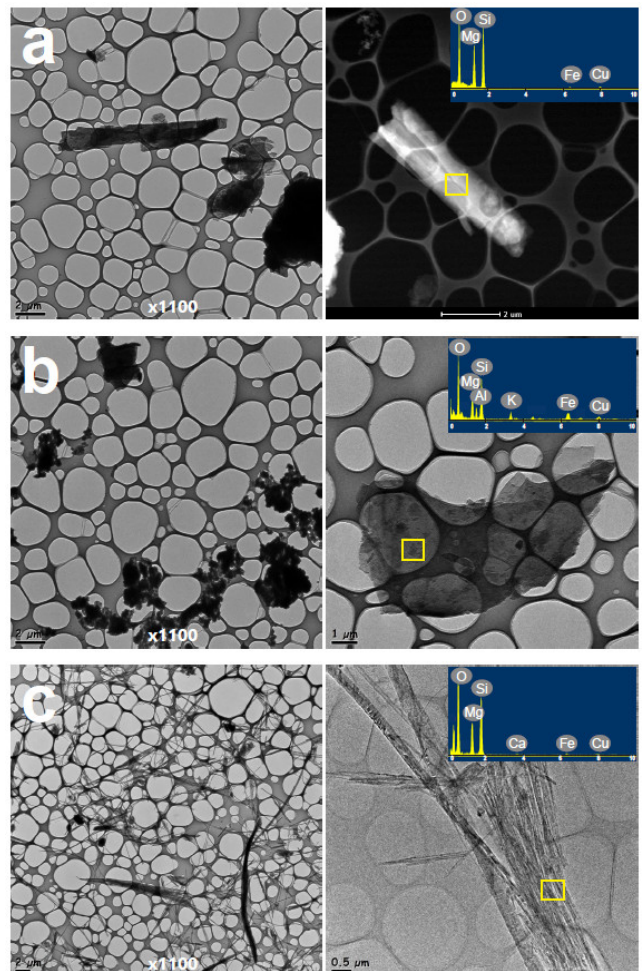
Figure 3. Representative TEM micrographs of asbestos in a sample with 0.1% ACMs: ( a ) talc, (b ) vermiculite, and ( c ) sepiolite. EDS analysis of the area (inset) further confirms the presence of silicate minerals.